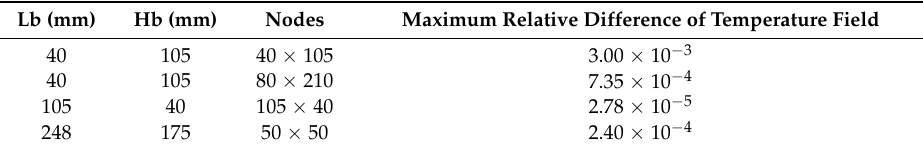
Table 1. Comparison of numeric solutions in steady state to Equation (5).